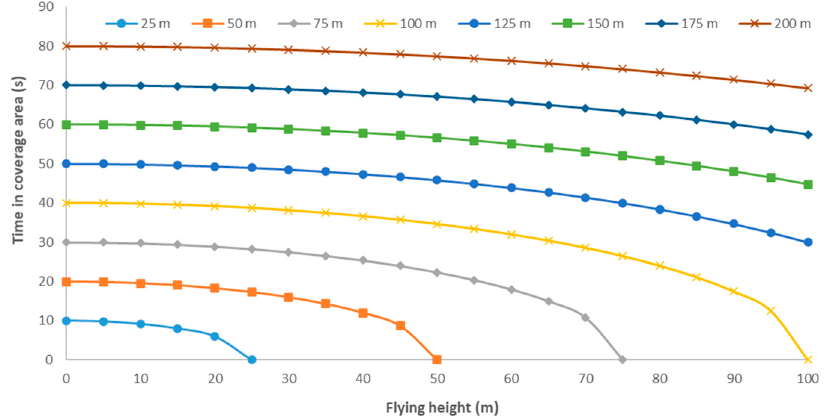
Figure 12. Time in coverage when a drone flies at 5 m/s and different dc .